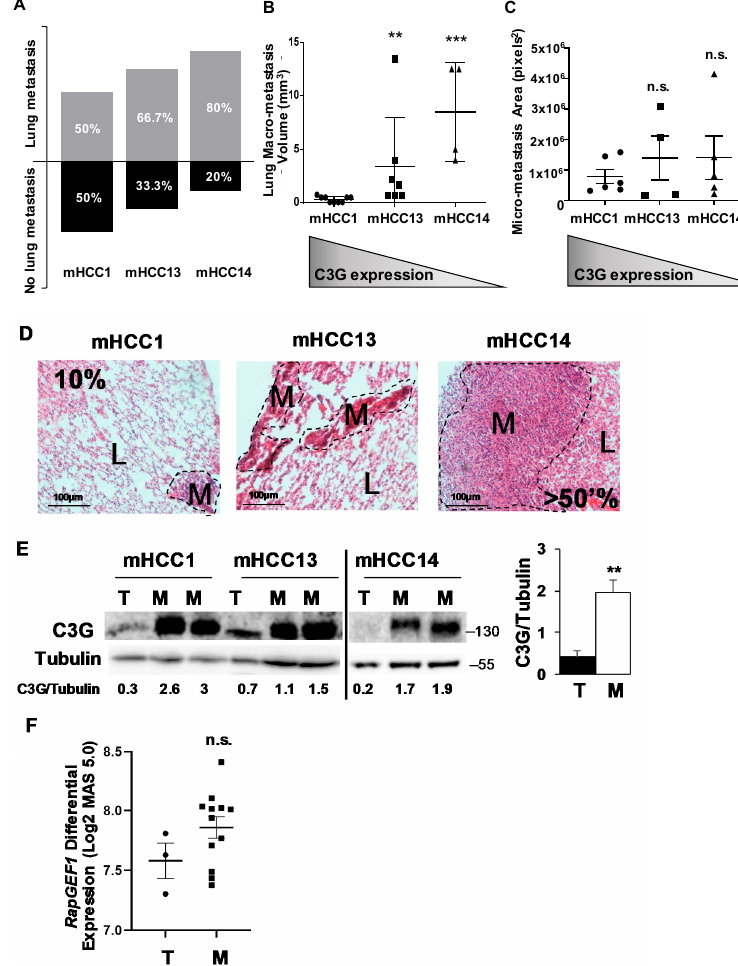
Figure 5. C3G expression inversely correlates with the lung metastatic potential of mouse Alb-R26 Met HCC cell lines. Mouse Alb-R26Met HCC cell lines (mHCC1, mHCC13, and mHCC14) were injected subcutaneously into mice flanks to generate tumors and lung metastasis. ( A ) Histogram showing the percentage of mice with and without lung metastasis for each mHCC cell line. ( B , C ) Scatter plots show the mean ± S.E.M of the volume (mm 3 ) of lung macro-metastases for each mHCC cell line (B) or the lung micrometastasis area (pixels 2 ) for each mHCC cell line ( C ), analyzed in Haematoxilin / Eosin-stained para ffi n-embedded lung sections using ImageJ. Kruskal–Wallis test was used. Grey triangle shows the corresponding decreasing levels of C3G in mHCC cell lines. ( D ) Representative images of the Hematoxylin / Eosin stained lung (L) and metastasis (M). Dotted lines delimit metastasis area. ** p ≤ 0.01, *** p ≤ 0.001 vs. mHCC1, using Kruskal–Wallis test followed by multiple comparison, n = 2. ( E ) Western-blot analysis of C3G levels in tumors and lung metastasis generated by mHCC cells normalized with Tubulin. Histogram represents the mean ± S.E.M of the quantification of C3G in several tumors and metastasis (relative values). ** p ≤ 0.01, tumors vs. metastasis using Student-t test, n = 4 ( F ) Scatter plot represent mean ± S.E.M. of RapGEF1 mRNA di ff erential expression levels in log2 MAS 5.0 signal of HCC primary tumors and lung metastasis from HCMDB (Human Cancer Metastasis Data Base) analyzed by Student’s t -test ( p = 0.17) vs. primary tumor. n.s.: